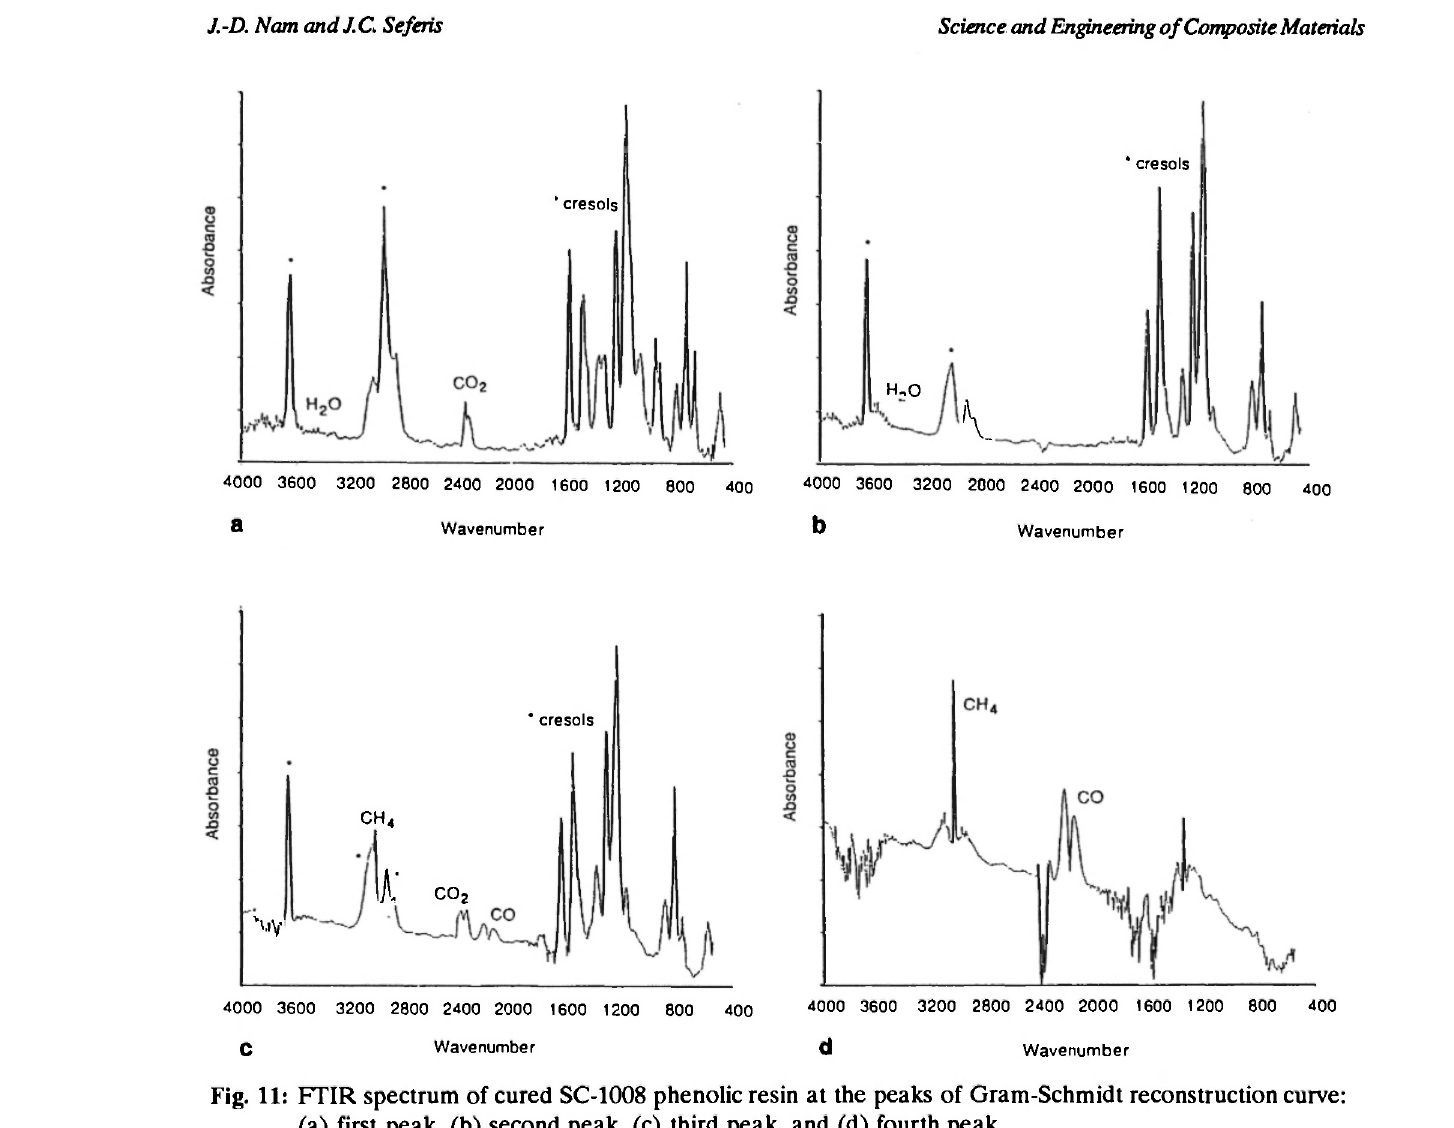
Fig. 11: FTIR spectrum of cured SC-1008 phenolic resin at the peaks of Gram-Schmidt reconstruction curve: (a) first peak, (b) second peak, (c) third peak, and (d) fourth